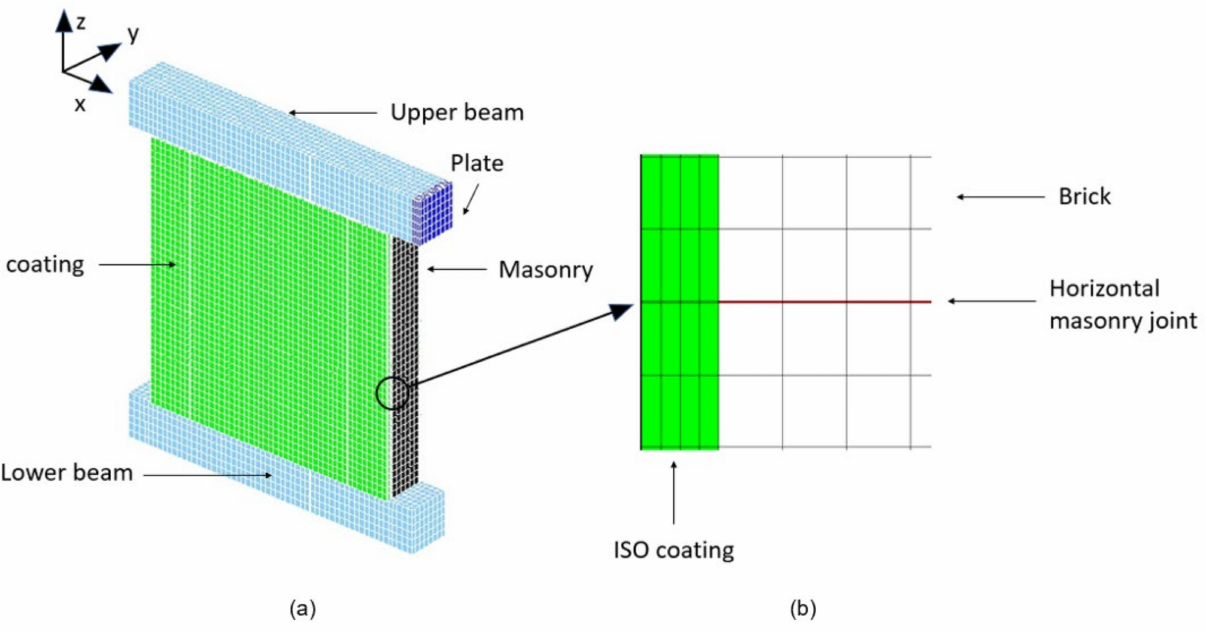
Figure 7. Numerical configuration for the URM wall ( a ) and front view of the masonry mesh ( b ). This figure was published in Computers and Structures, Vol 254, Jean-Patrick Plassiard, Ibrahim Alachek, Olivier Pl é , Damage-based finite-element modelling of in-plane loaded masonry walls repaired with FRCM, Page, Copyright Elsevier (2021) [30].